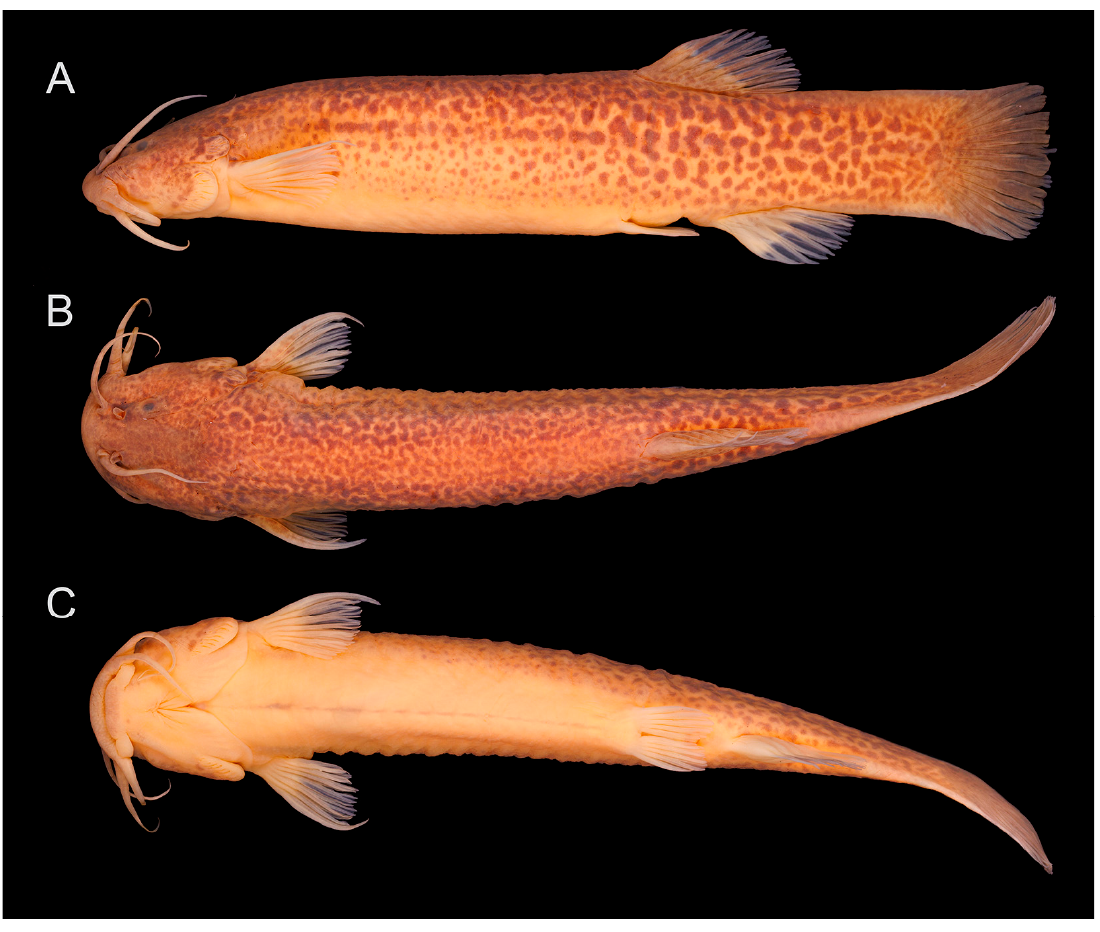
Figure 9. Trichomycterus (Cryptocambeva) pirabitira , UFRJ 7279, Conceição da Aparecida, 65.7 mm SL: ( A ) lateral, ( B ) dorsal, and ( C ) ventral views.